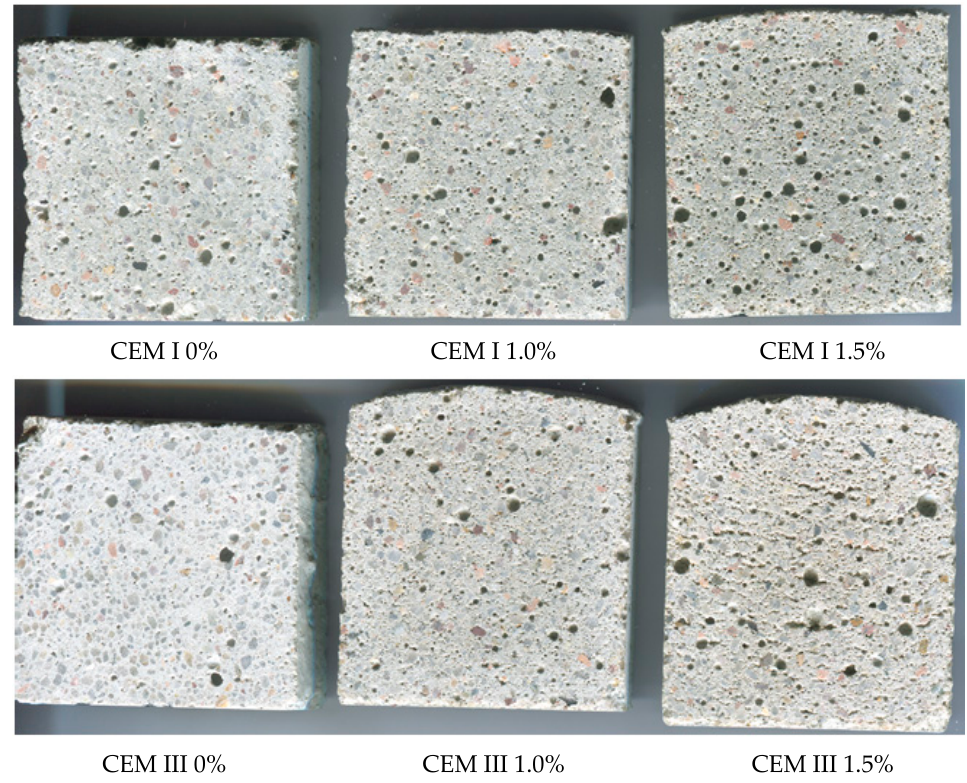
Figure 4. Images of sample cross-sections of mortars without and with the gas-liberating admixture.